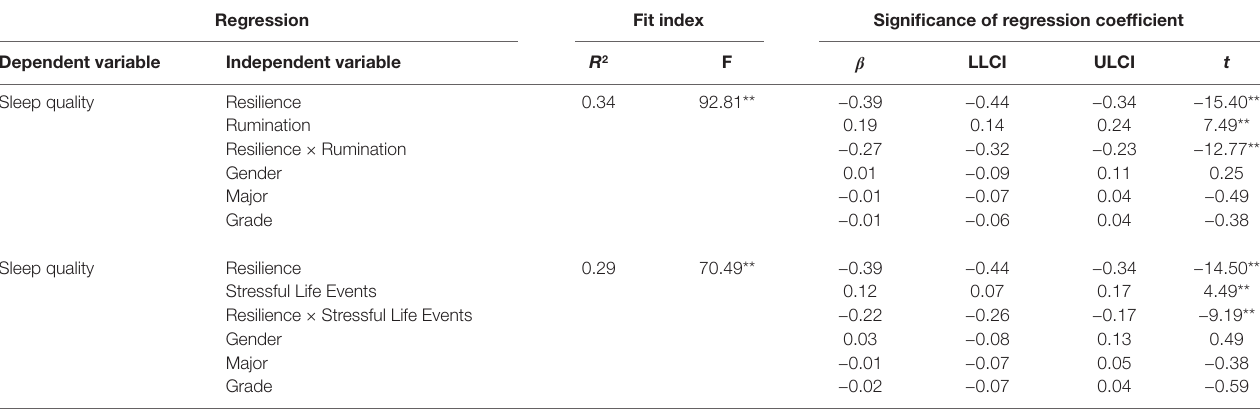
TABLE 3 | Multiple regression analyses of the moderate effect of resilience.